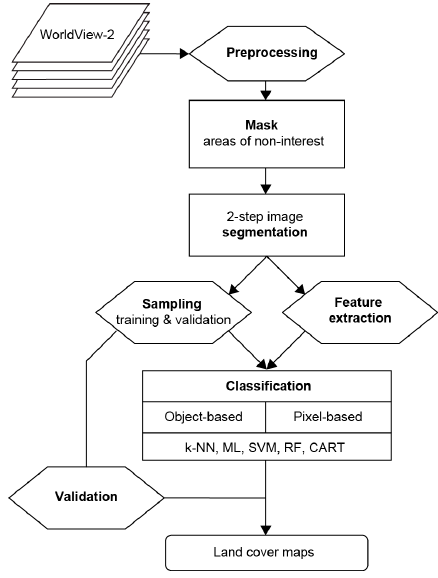
Figure 3. General workflow to derive savanna components.